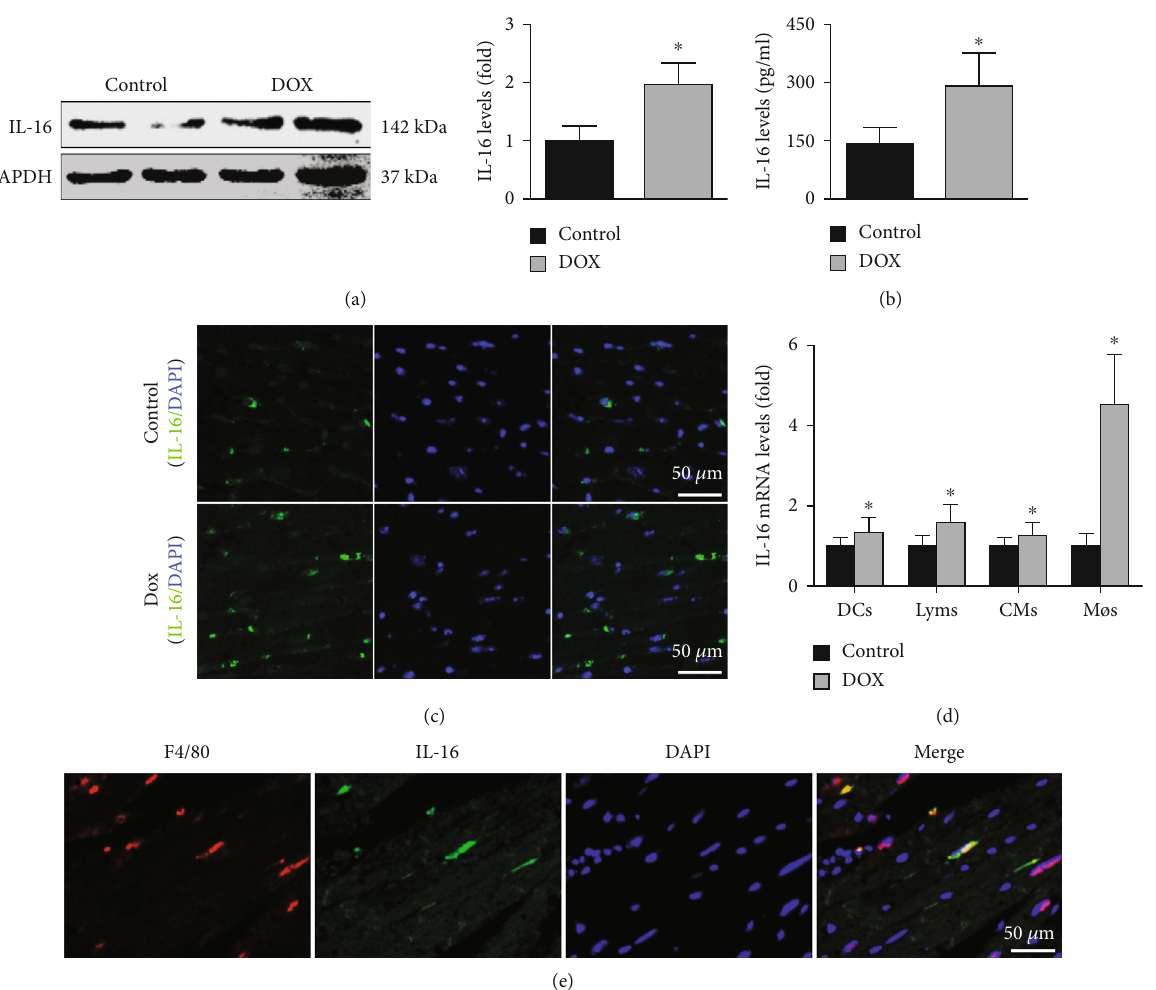
Figure 1: E ff ects of DOX on cardiac IL-16 expression. (a, b) Cardiac IL-16 expression and serum IL-16 levels were measured in the control and DOX groups (nonparametric test). (c) Cardiac IL-16 expression in the 2 groups was determined by immuno fl uorescence staining (200x). (d) E ff ects of DOX on IL-16 mRNA expression in CTLL-2 T lymphocytes (Lyms), RAW264.7 macrophages (Møs), DC2.4 dendritic cells (DCs), and HL-1 cardiomyocytes (CMs) (Student ’ s t -test). (e) Double immuno fl uorescence staining with anti-F4/80 and anti-IL-16 in DOX-induced mice (200x). N = 5 in each group. ∗ p < 0 : 05 vs. the control